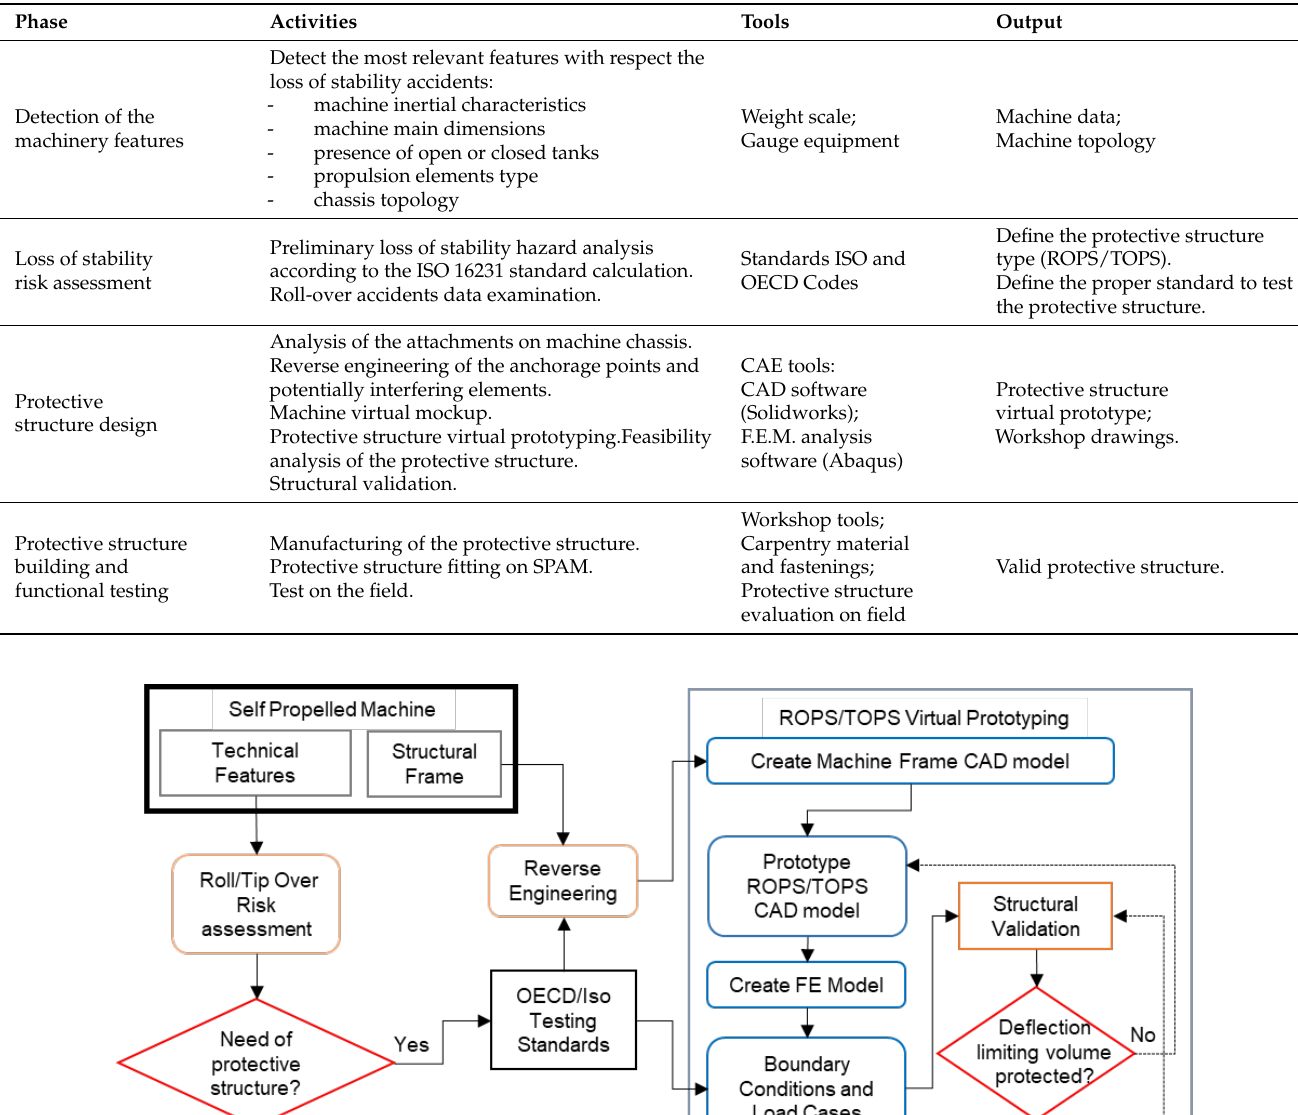
Table 1. Main phases of protective structure manufacturing and fitting to machinery.